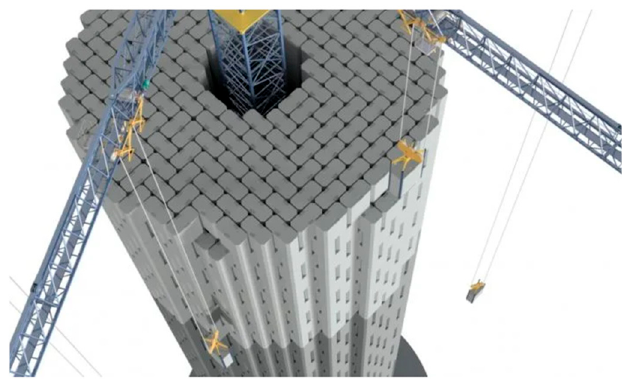
Figure 17. Picture of the crane that is meant to be used in the project. Energy Vault in Milan, Italy, in 2018 completed the construction of one-tenth of the full-scale operation. Each barrel of the one-tenth model project weighed 500 kg and was 20 m in height. The full-scale operation is expected to have a capacity of 20 MW, enough to power 2000 houses, having an efficiency of 85%. One-tenth of the full-scale project took less than $2 million to complete in nine months. Each barrel is lifted by a 120 m six-armed crane, and weighs 35 tons. The crane is equipped with a computer that is programmed to deliver an algorithm that operates the crane arms to identify and locate the barrel. This function is executed using a camera that is attached to the crane arm’s trolley. The hardware used to build this project is available prefabricated. The concrete used in the project costs less than using other conventional energy storage methods such as Li-ion cells. Inorganic waste